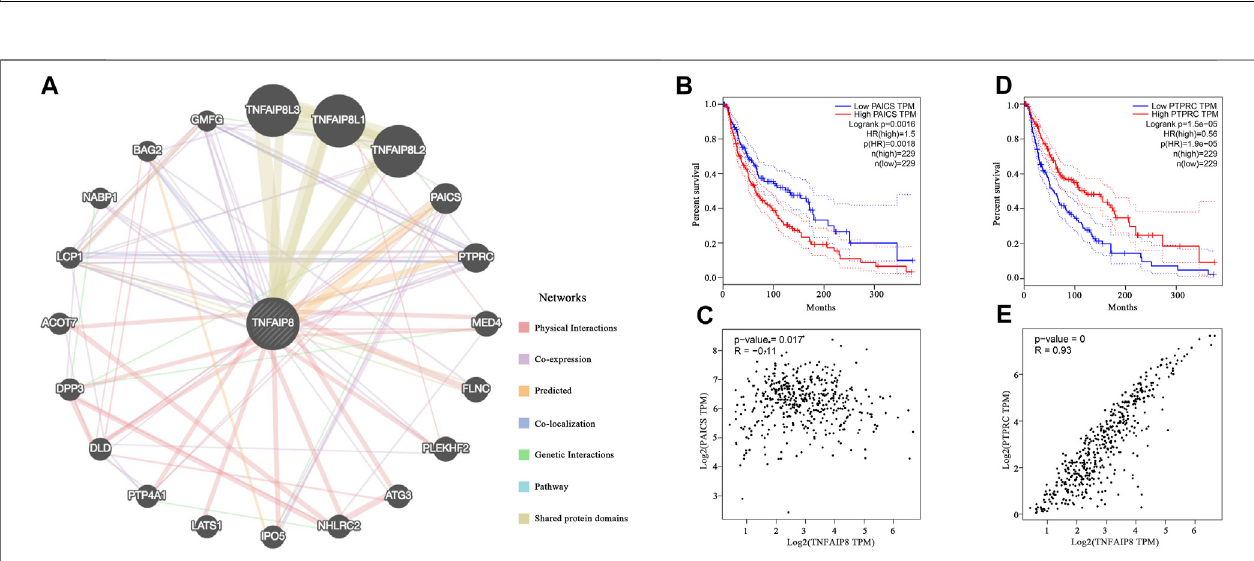
FIGURE 4 | Protein – protein interaction network prediction of TNFAIP8. (A) Integrated protein – protein interaction network of TNFAIP8 via GeneMANIA. (B) The overall survival analyses and (C) TNFAIP8 correlation of PTPRC in SKCM (GEPIA). (D) The overall survival analyses of PAICS in SKCM via GEPIA. (E) The correlation analysis between TNFAIP8 and